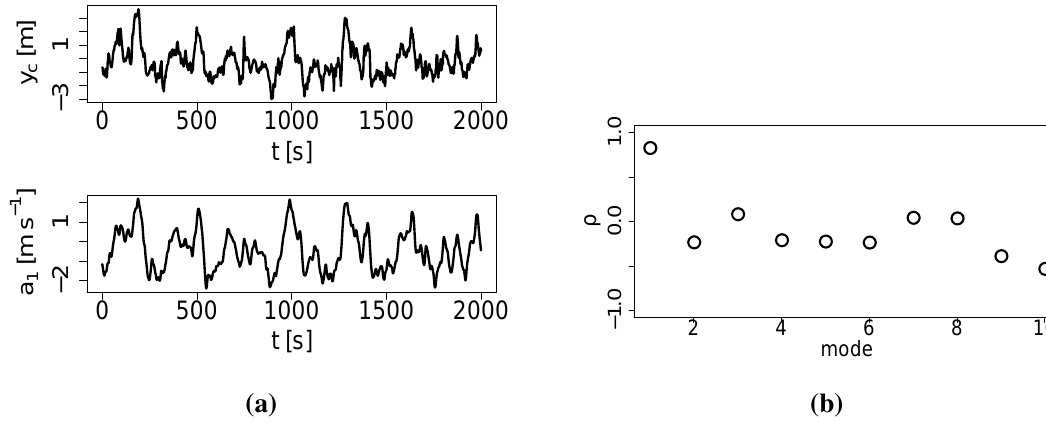
Figure 12. ( a ) Time series of the first weighting coefficient a of the deficit y ; ( b ) correlation coefficients ρ of the horizontal deficit position y c weighting coefficients of the first 10